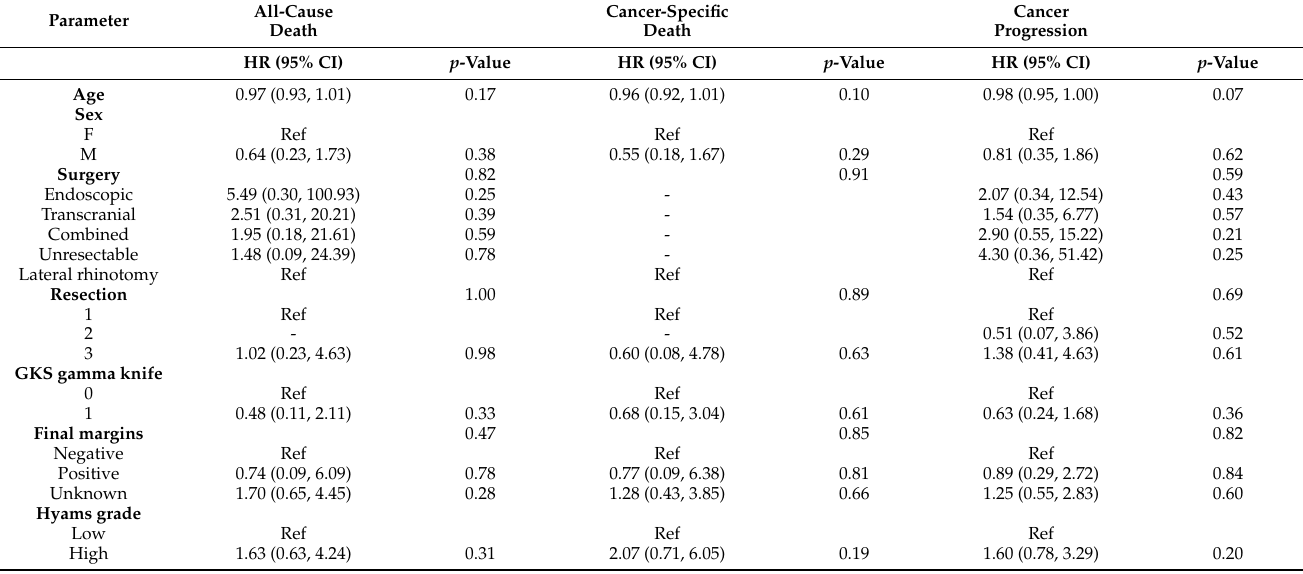
Table 9. Univariable hazard ratios of demographic and medical